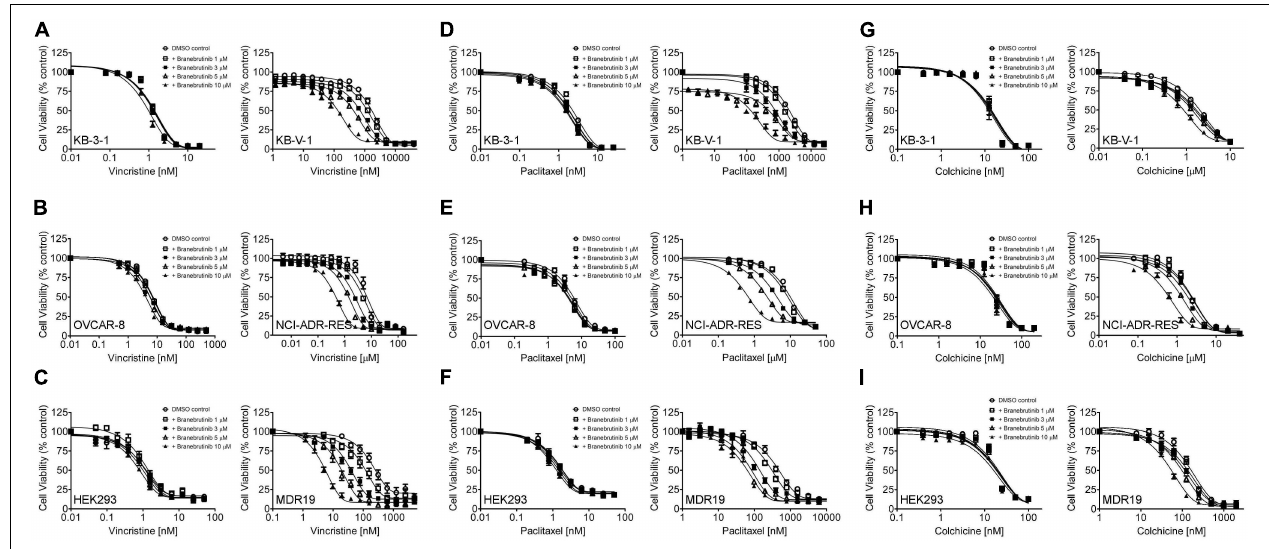
FIGURE 1 | Branebrutinib reverses multidrug resistance (MDR) in P-glycoprotein (P-gp) -overexpressing cells. The effect of branebrutinib on P-gp-mediated resistance to vincristine (A–C) , paclitaxel (D–F) and colchicine (G–I) was tested in drug-sensitive parental human KB-3-1 epidermal cancer cell line (A,D,G-left panel) and its P-gp-overexpressing multidrug-resistant KB-V-1 subline (A,D,G-right panel) ; drug-sensitive parental human OVCAR-8 ovarian cancer cell line (B,E,H-left panel) and its P-gp-overexpressing multidrug-resistant NCI-ADR-RES subline (B,E,H-right panel) ; as well as parental HEK293 cells (C,F,I-left panel) and MDR19-HEK293 cells, which are HEK293 cells transfected with human P-gp (C,F,I-right panel) . Cells were treated with increasing concentration of vincristine, paclitaxel or colchicine in the presence of DMSO (open circles) or branebrutinib at 1 µ M (open squares), 3 µ M (filled squares), 5 µ M (open triangles), or at 10 µ M for 72 h before analysis as described in Materials and methods. Points, mean values from at least three independent experiments; bars; S.E.M.